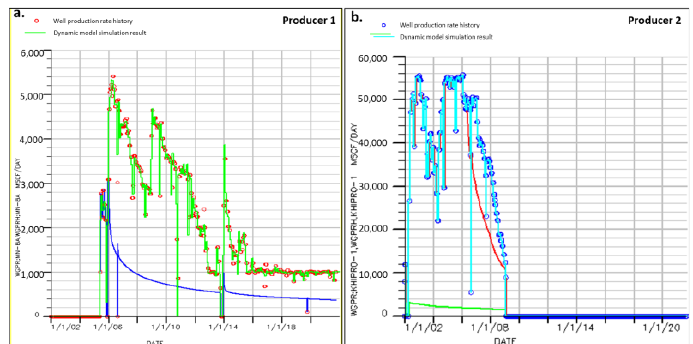
Figure 26. The production rate history and simulation result from the dynamic model (built based on the static reservoir model) of producer 1 ( a ) and producer 2 ( b ). The two producers are producing from both the conventional and the tight gas reservoirs. Good history-matching results indicate the reliability of the static reservoir model.